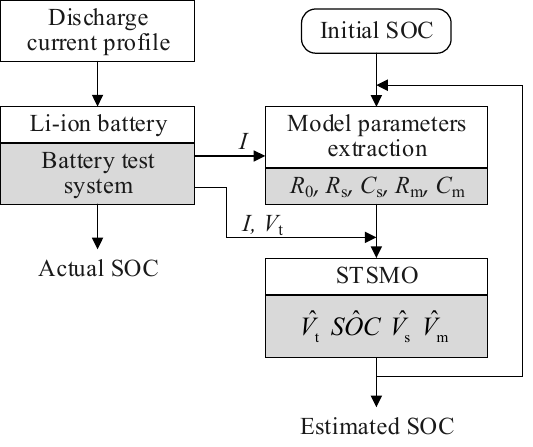
Figure 8. Configuration of the super-twisting sliding mode observer (STSMO) system.